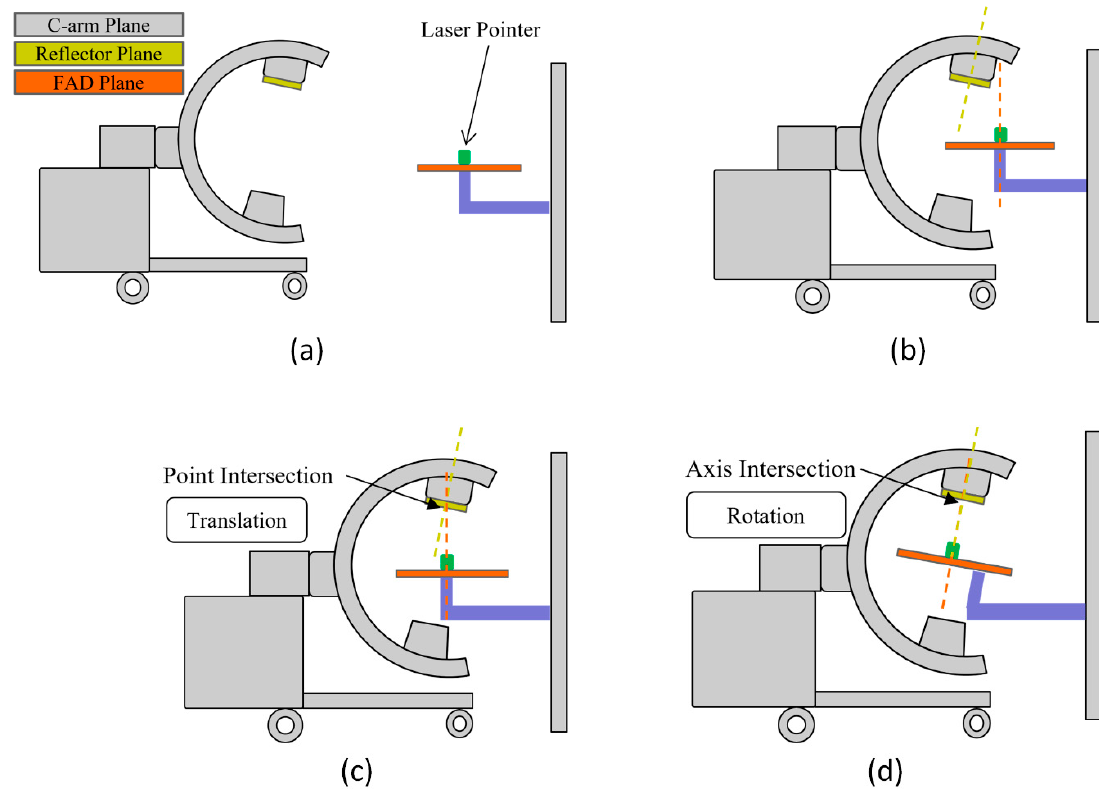
Figure 5. The procedure of alignment between the C-arm and FAD. ( a ) The initial state of the C-arm and FAD. ( b ) Rough alignment to place the PGSLP within range of the X-ray. ( c ) Translation adjustment to move the laser image near the center of the C-arm panel. ( d ) Rotation adjustment to make the two planes parallel.